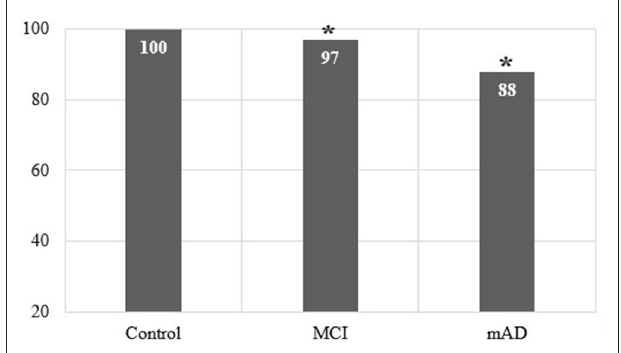
FIGURE 1 | Percentages of correct responses in grammatical aspect for the three groups of participants. The asterisk indicates significant effects ( p <